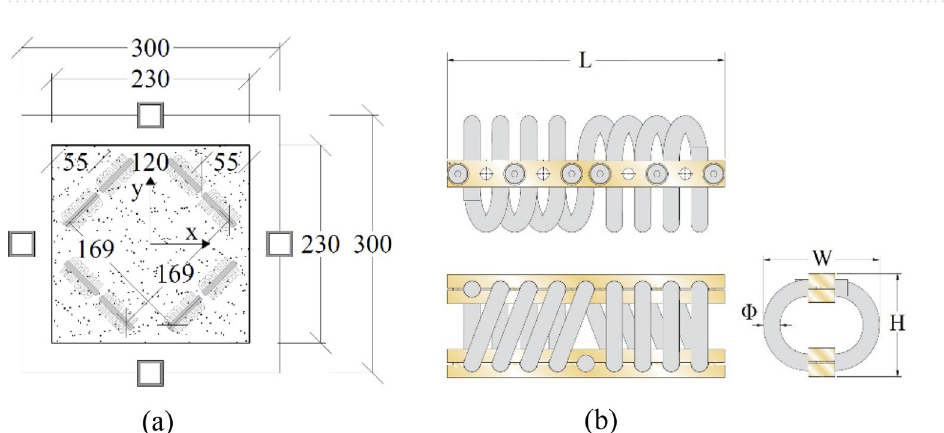
Figure 2. ( a ) Configuration of a single unit cell equipped with steel wire ropes; ( b ) details of a single wire rope. Dimensions are in